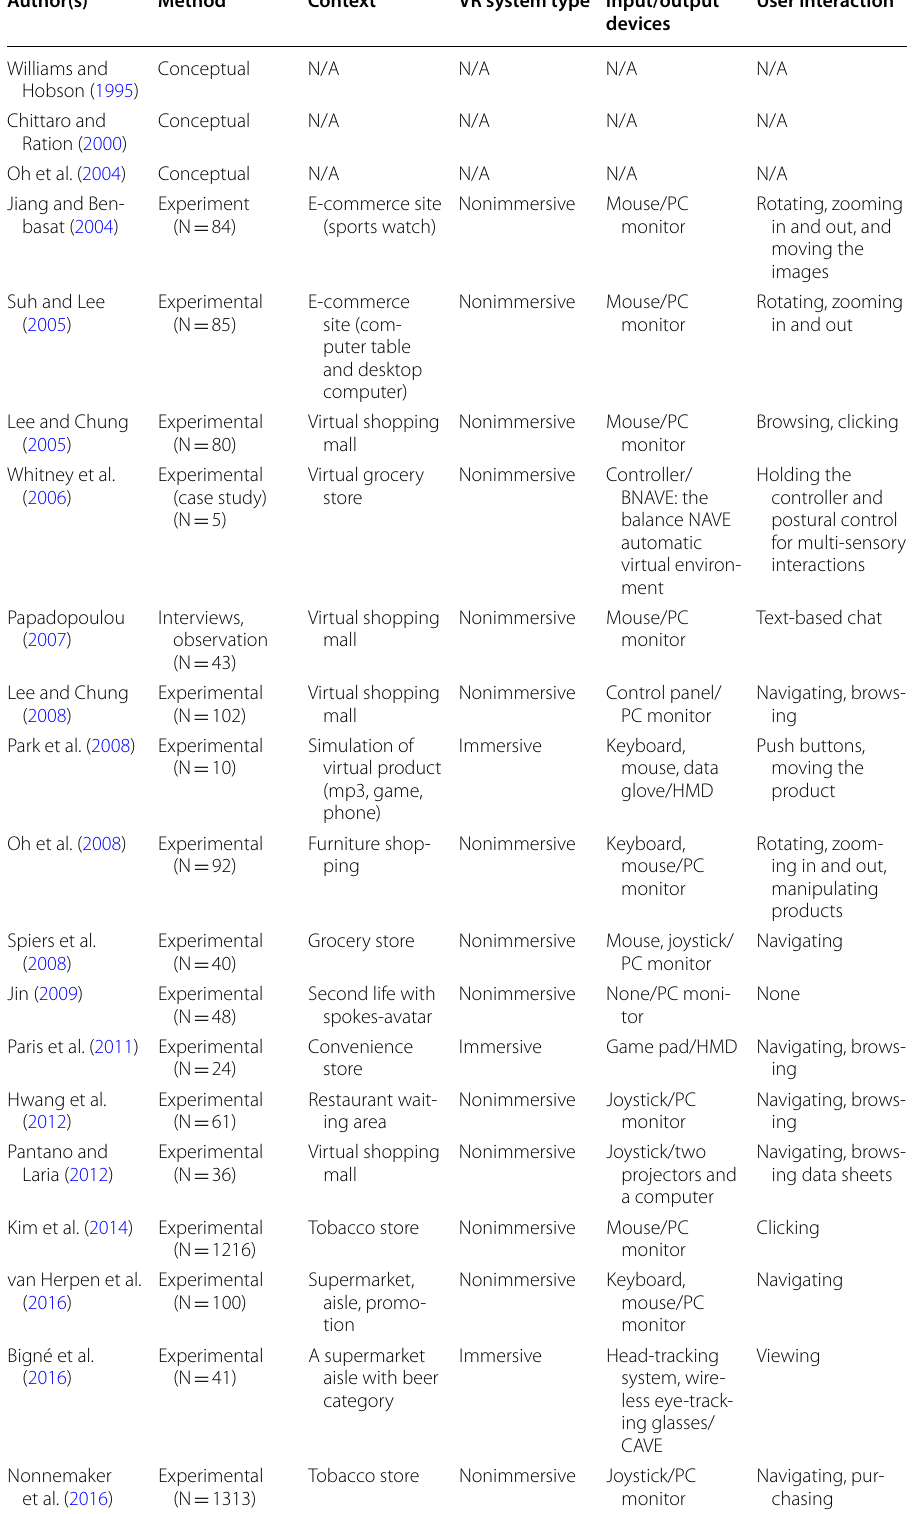
Table 2 Research on the virtual reality and retailing in chronological